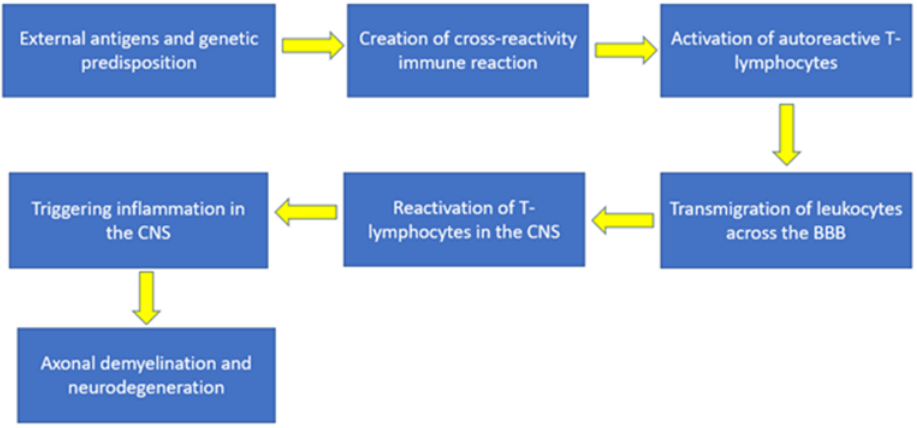
Figure 1. The summarized scheme of MS pathogenesis .